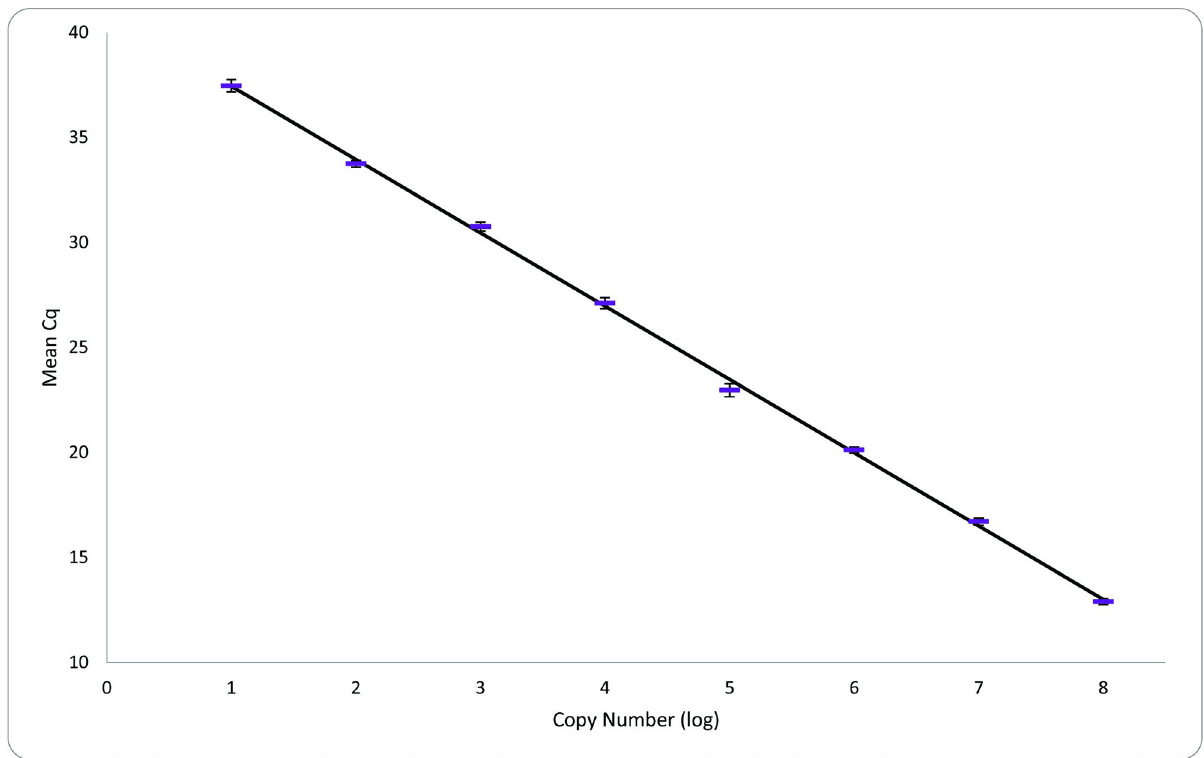
Fig 2. Guinea worm ( Dracunculus medinensis ) qPCR standard curve generated using 12 sets of 10-fold dilutions of plasmid run in triplicate. The x-axis is the log copy number of the plasmid at each dilution, and the y-axis is the C q value. The mean C q values ( ± SE) are plotted.